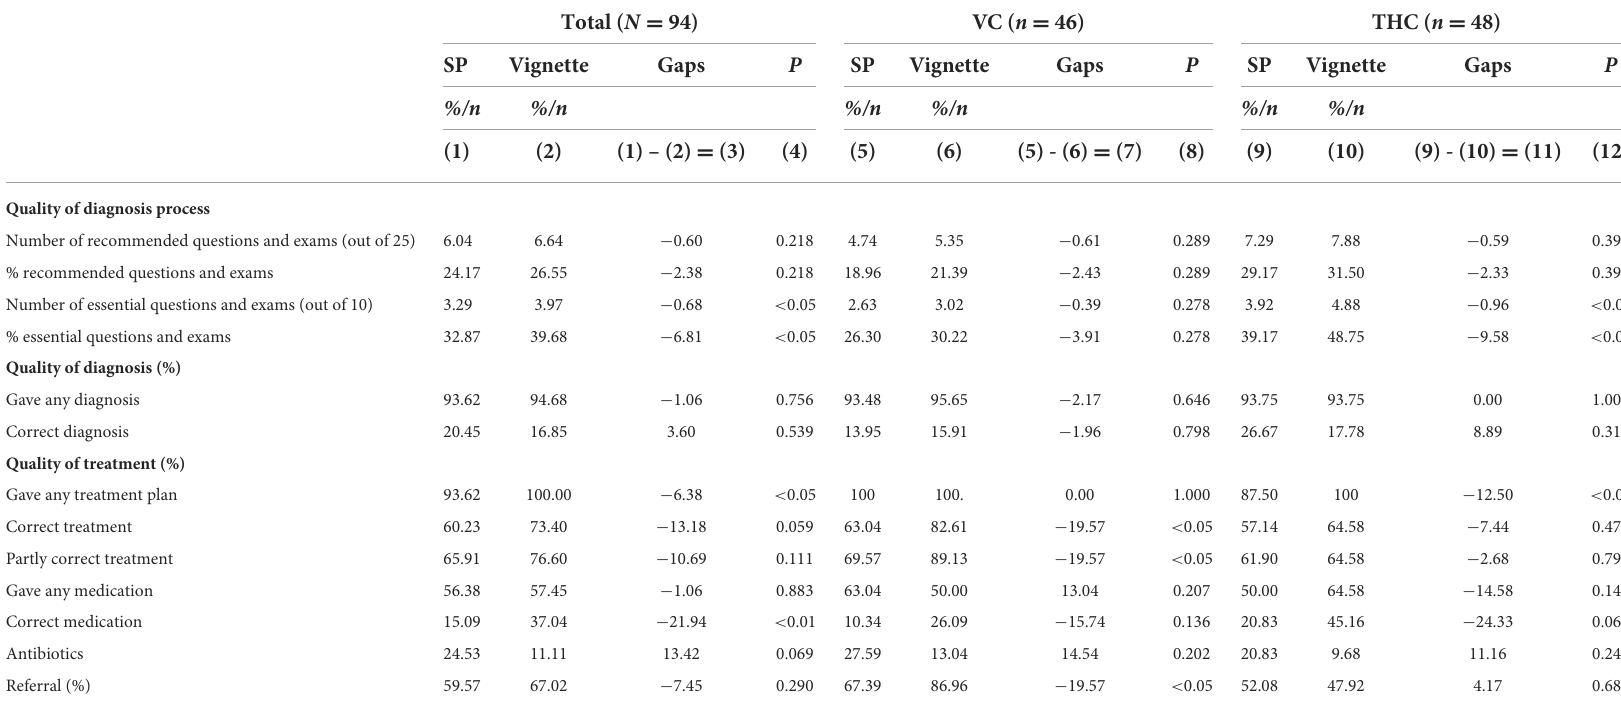
TABLE 7 The know-do gap of diagnostic questions asked, and diagnosis and treatment given for angina cases in Village Clinics (VCs) and Township Health Centers